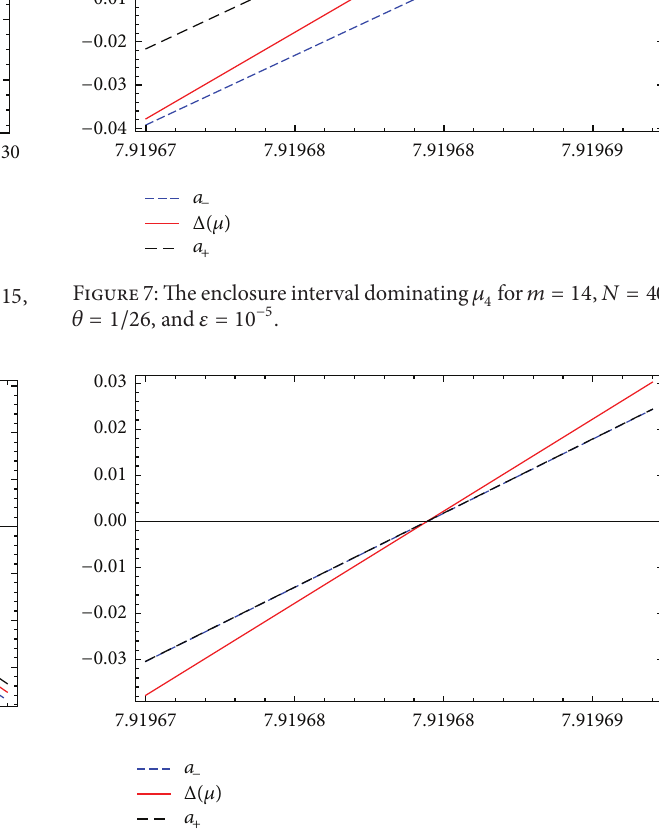
Figure 8: The enclosure interval dominating 𝜇 4 for 𝑚 = 14 , 𝑁 = 40 , 𝜃 = 1/26 , and 𝜀 = 10 −10